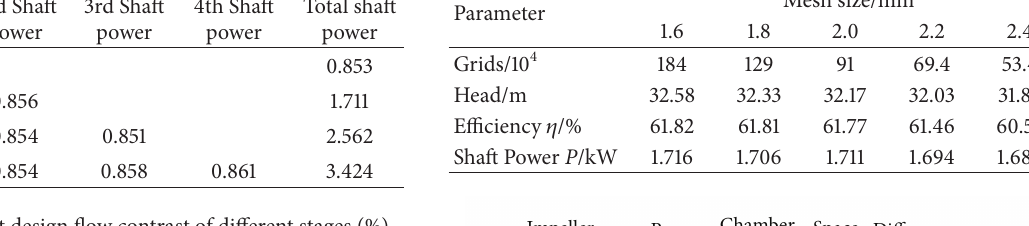
Table 6: Efficiency at design flow contrast of different stages (%).